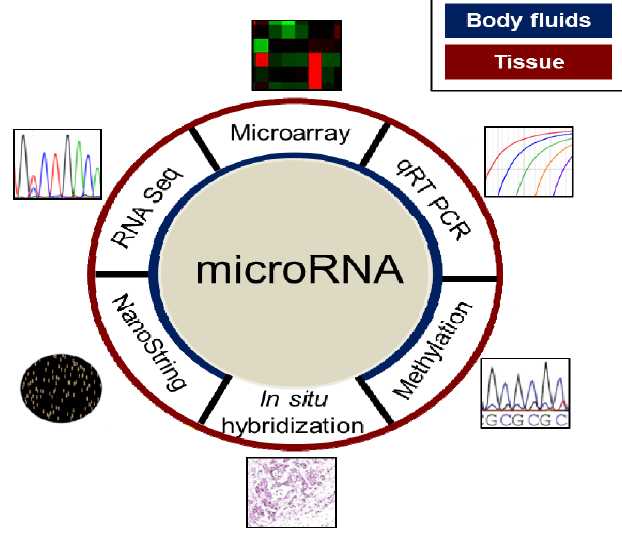
Figure 1. Overview of the different molecular techniques applied in the study of miRNA dysregulation in human pathology. All techniques could be applied to tissue sample ( red circle ; both fresh and formalin-fixed paraffin-embedded) and body fluids samples ( blue circle ; mainly urine and